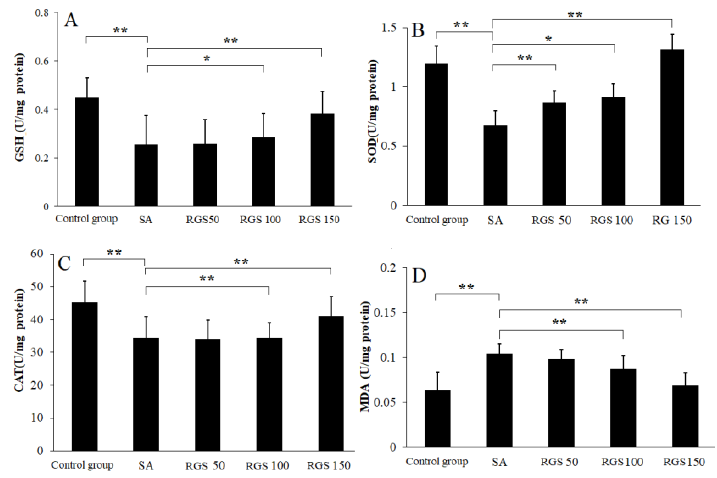
Figure 1. Effects of ( A ) glutathione (GSH), ( B ) superoxide dismutase (SOD), ( C ) catalase (CAT) and ( D ) malondialdehyde (MDA) levels in scopolamine-treated rats after pretreatment of red ginseng saponins (RGS). Values are expressed as mean ± SD (n = 6). * p < 0.05, ** p < 0.01. (one-way ANOVA followed by Tukey post hoc multiple comparison test).